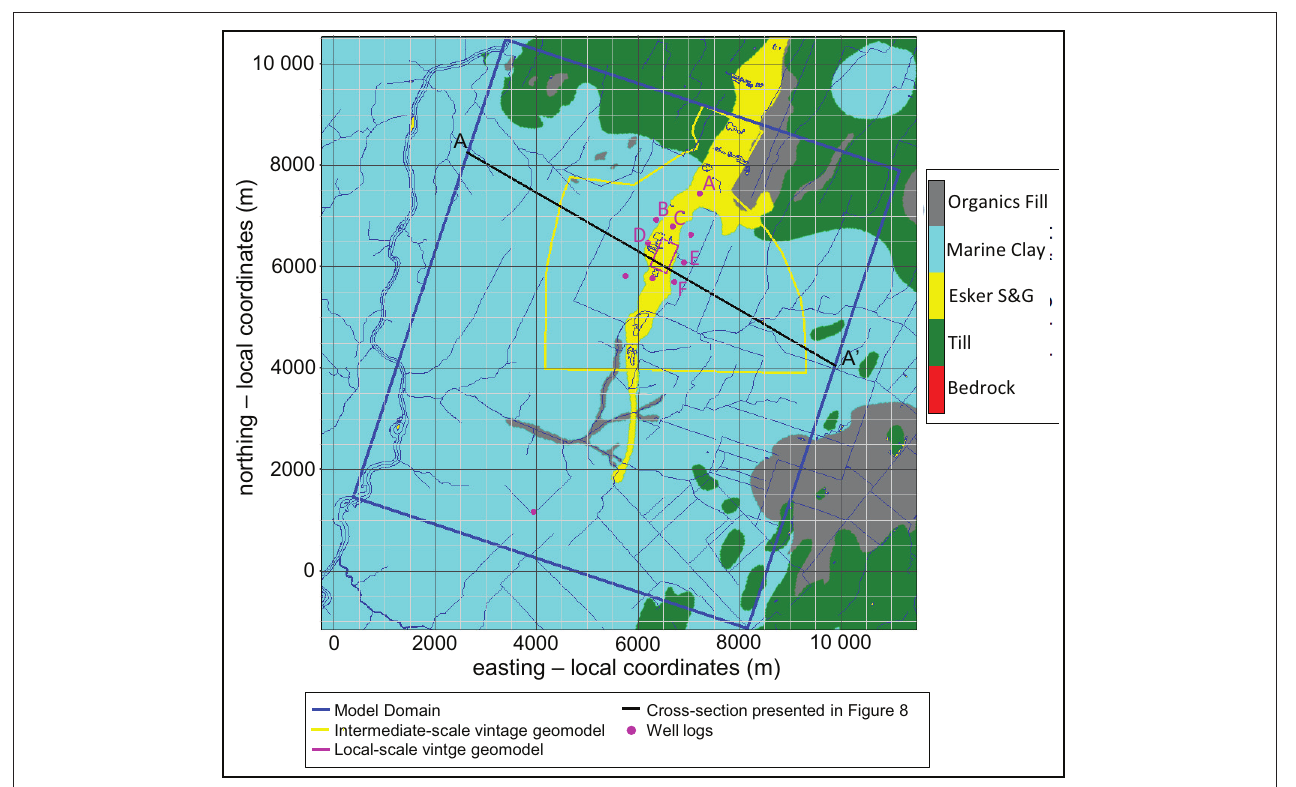
FIGURE 2 | Map of surface geology in the model